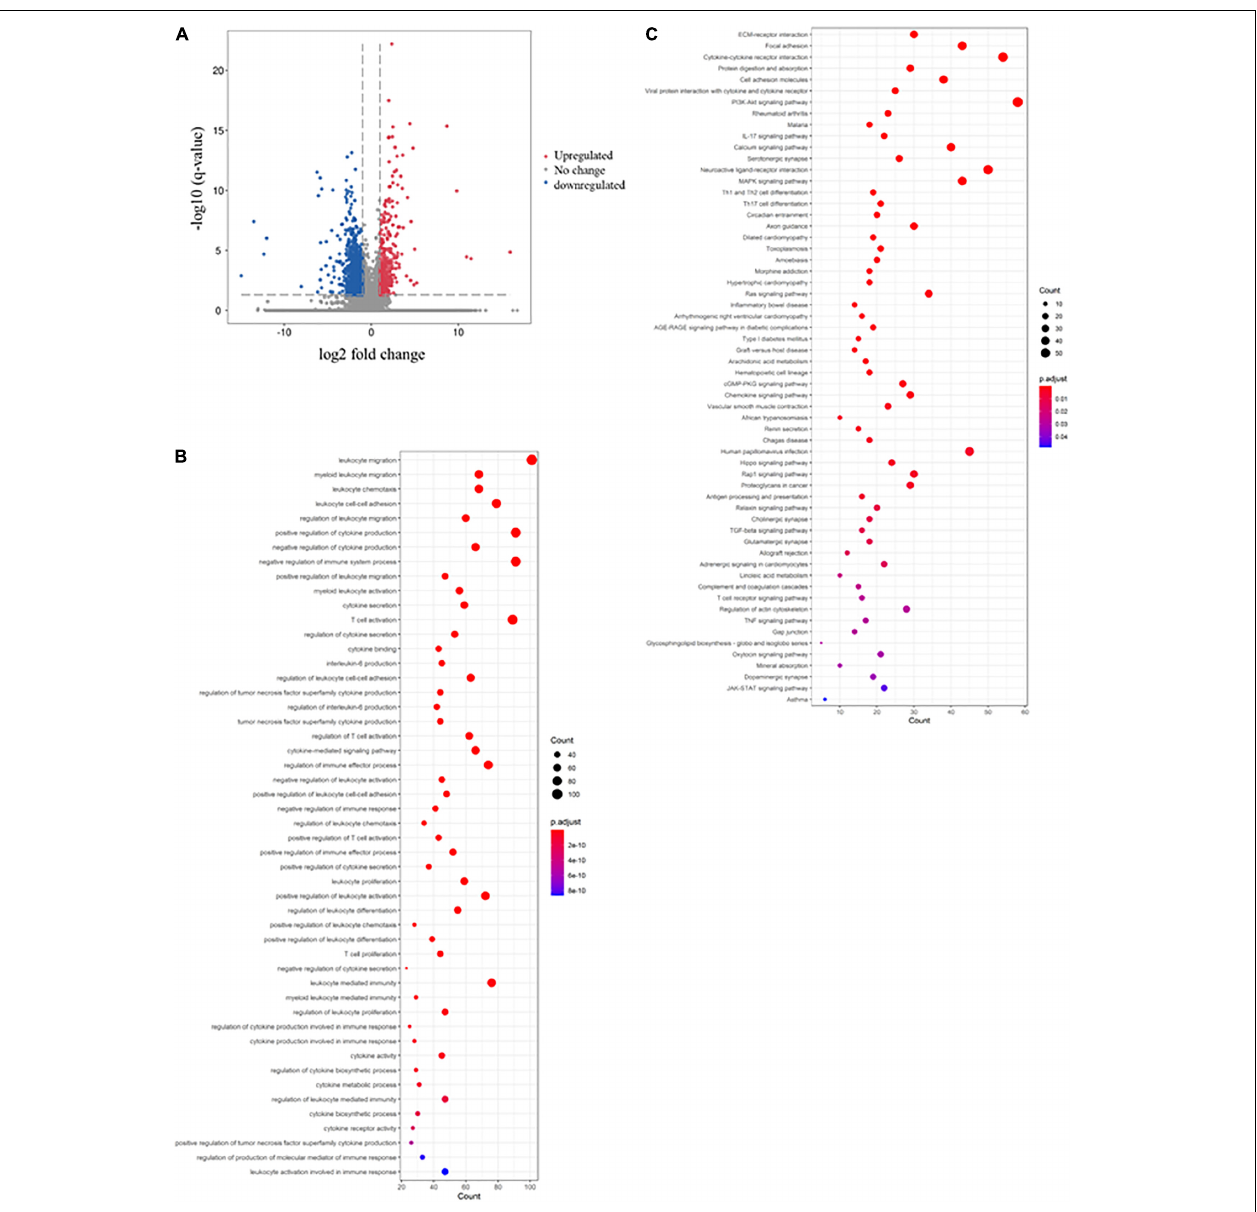
FIGURE 2 | Immunosuppressive effects of mesalazine on DSS-induced colitis. The volcano plot shows the differential expression of genes in the mesalazine-treated colitis mice. The genes with | log 2 (fold change: mesalazine + DSS/DSS)| > 1 and -log B and H corrected p -value > 1.3 were considered DEGs. The red dot represents upregulated genes, the green dot represents downregulated genes, and the gray dot represents genes with no significant change. (B) The rich factor plot shows the alteration of biological processes related to immunity in the gut of mesalazine-treated mice with colitis. The size of the dot represents the number of DEGs. The color intensity of the dots represents the significance of the biology processes. (C) The rich factor plot showed the alteration of cell signaling pathways related to immunity in the gut of mesalazine-treated colitis mice. The size of the dots represents the number of DEGs. The color intensity of the dots represents the significance of the signaling